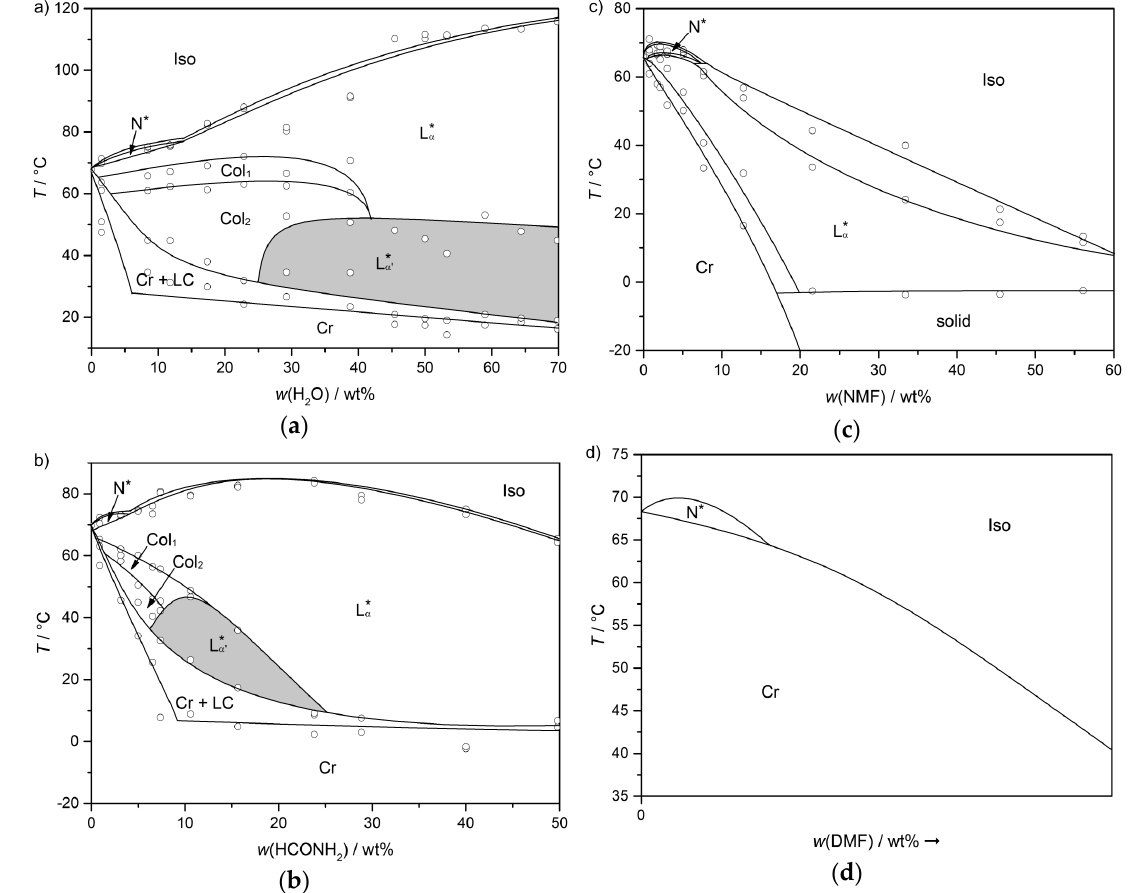
Figure 22. Phase diagrams of the amphiphile 4 with ( a ) water, ( b ) formamide, ( c ) N -methylformamide and ( d ) N , N ,-dimethylformamide. The ability of the solvent to stabilize lyotropic mesophases in general—and the lyotropic SmC* phase in particular—is diminished in the order of presentation. For the system 4 / DMF, only a schematic phase diagram is presented, which was derived by investigation of a contact sample. (Reprinted by permission from John Wiley and Sons: [45].)